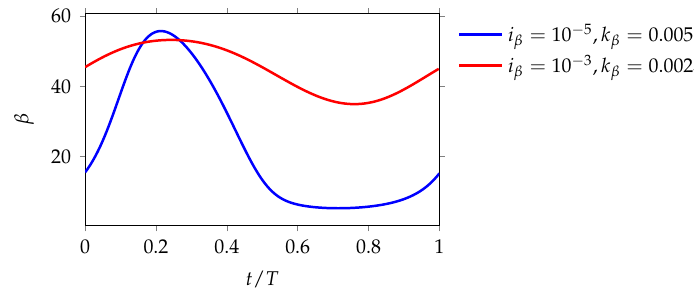
Figure 10. Flap deflection in one time period of lift cycle.